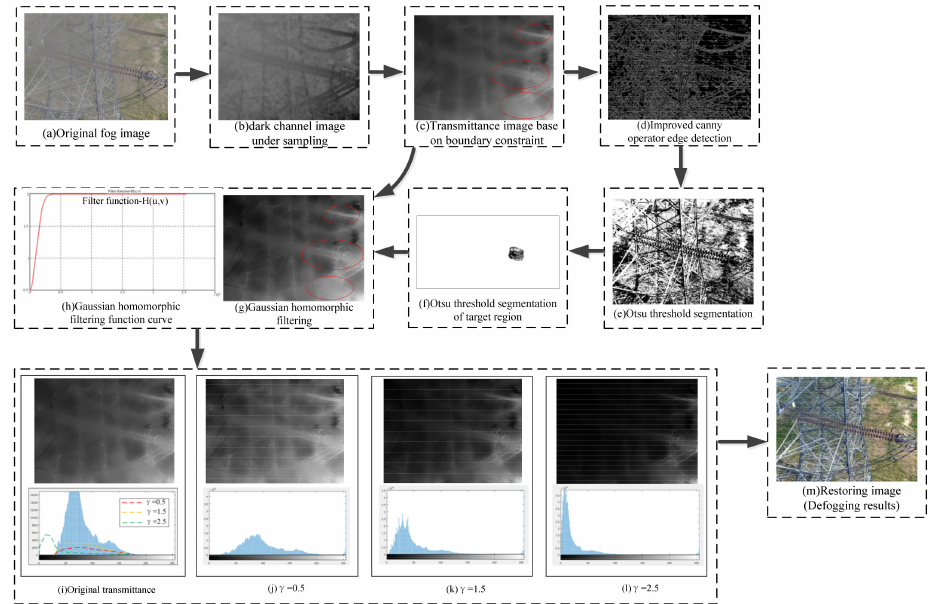
Figure 10. Experimental results of improved dark channel defogging